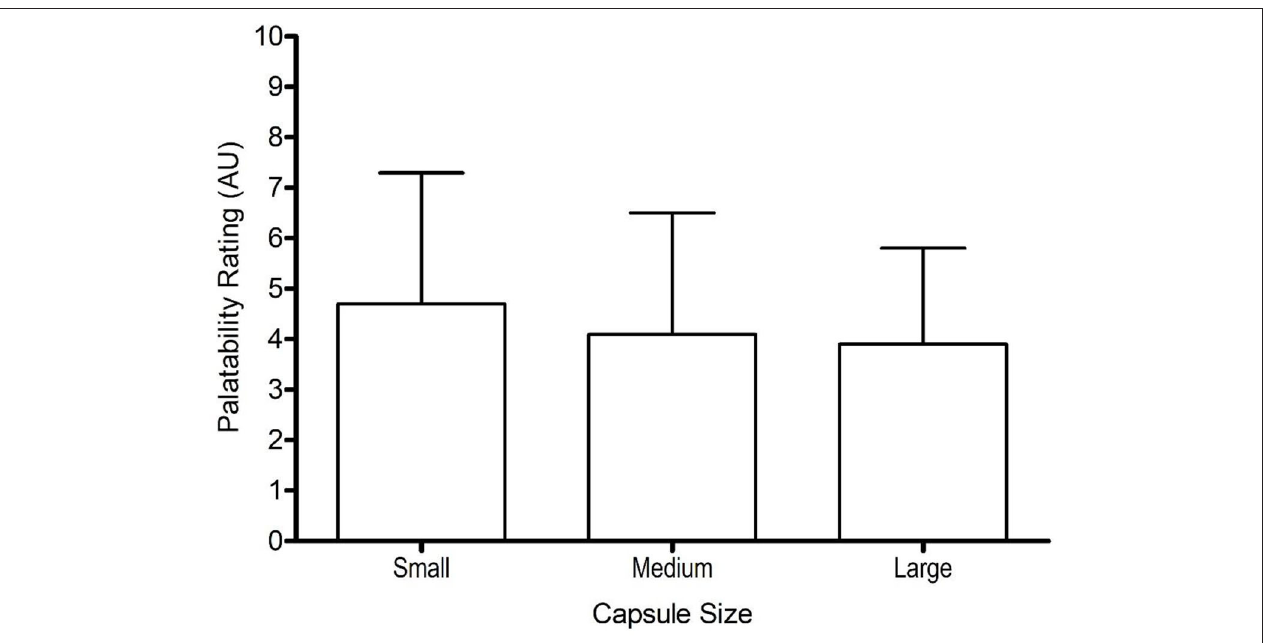
FIGURE 3 | Mean ( ± SD) palatability scores following the consumption of 0.3 g · kg − 1 body mass NaHCO 3 in small-, medium-, and large-sized